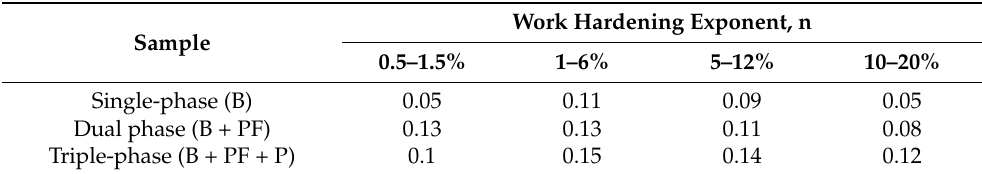
Table 3. The work hardening exponent of three samples.